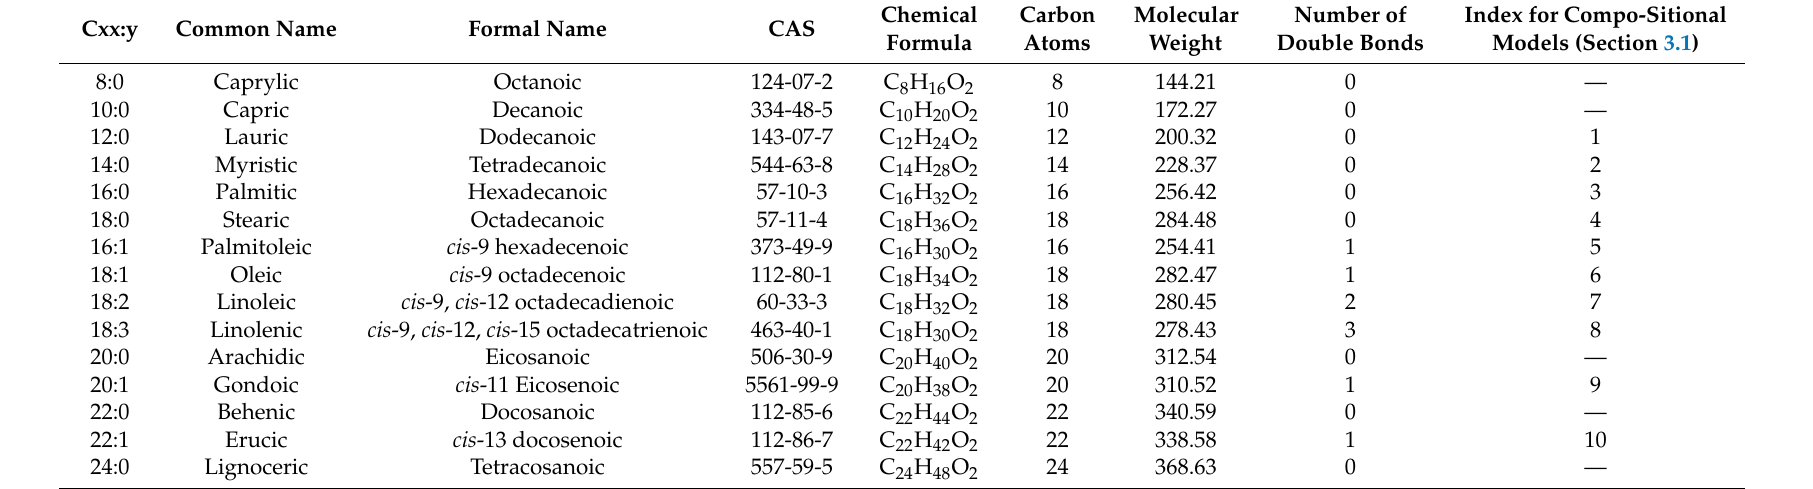
Table 1. Common fatty acids found in biodiesel